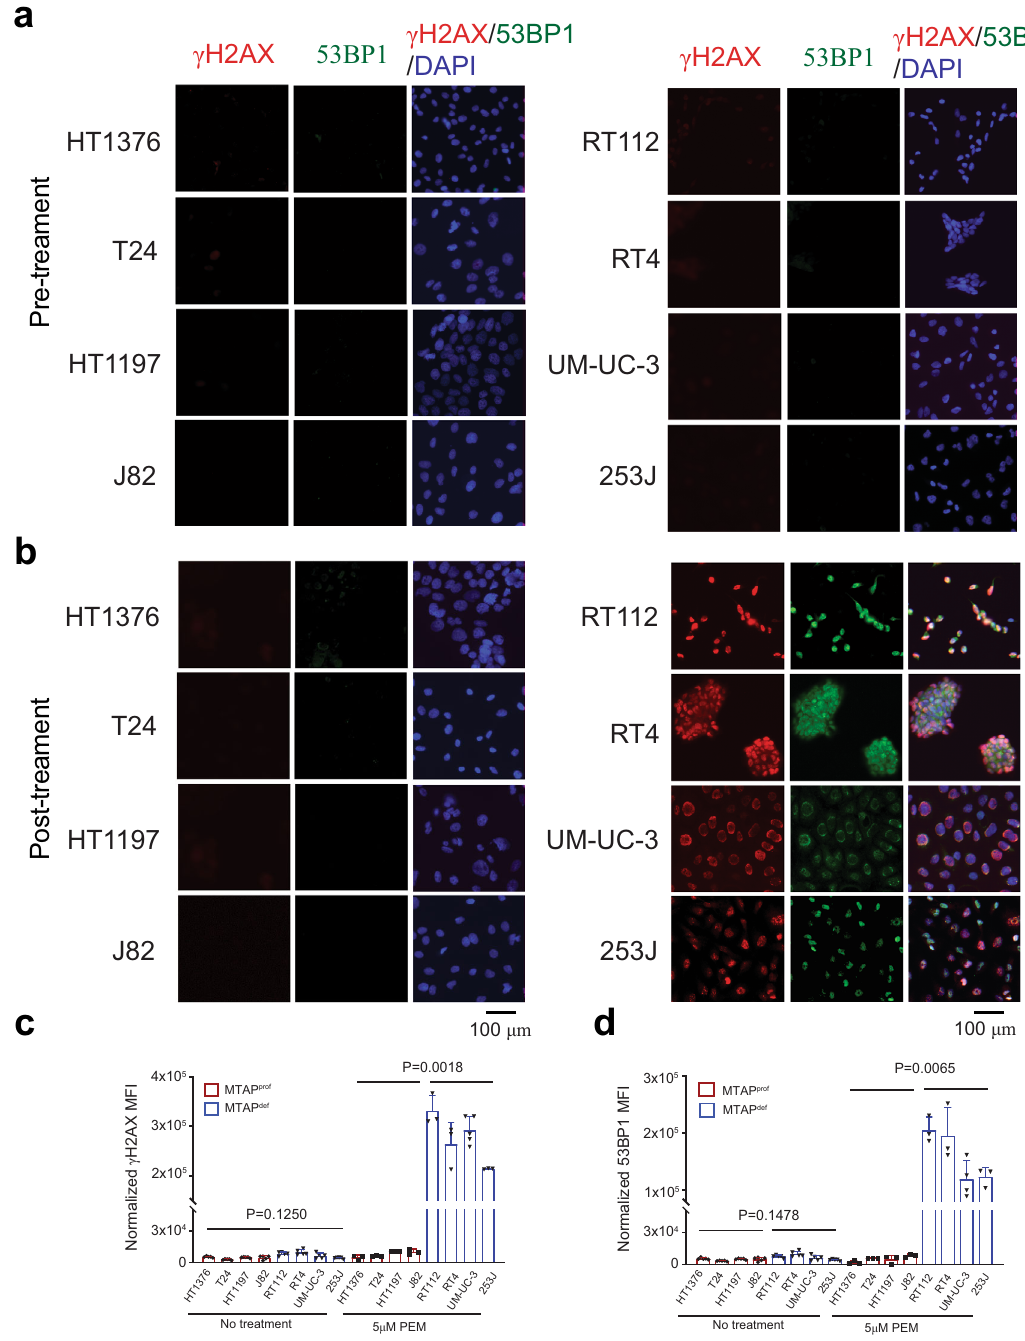
Fig. 3 Pemetrexed (PEM) induces signi fi cantly higher DNA damage in MTAP def cell lines as compared to MTAP prof cell lines. Eight human bladder cancer cell lines were treated with no treatment ( a ) or 5 μ M of PEM ( b ) for 24 h. Cells were then fi xed and stained with γ -H2AX (red), and 53BP1 (green) antibodies as well as DAPI stain (blue). Images were quanti fi ed with ImageJ for γ -H2AX ( c ) and 53BP1 ( d ). Data represent mean ± SEM of four fi elds and analyzed with Welch T